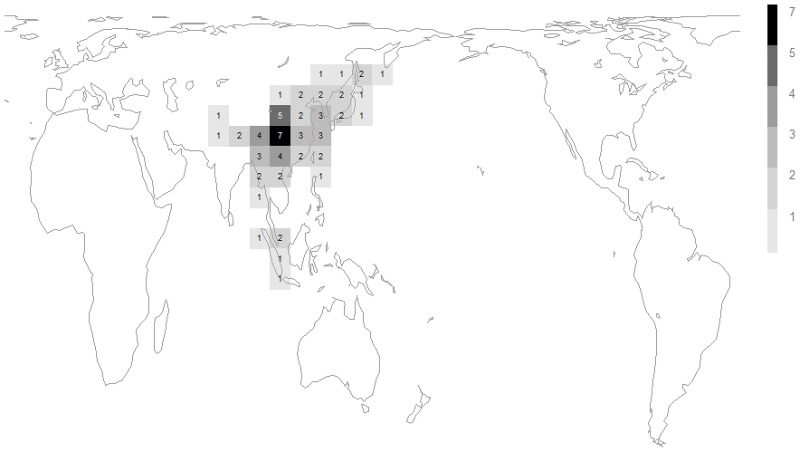
Diversity from different phases of speciation of the subgenus Megabombus.Data sources and grid map as in Fig 5. Richness in the species B. montivagus to B. securus from Fig 4.